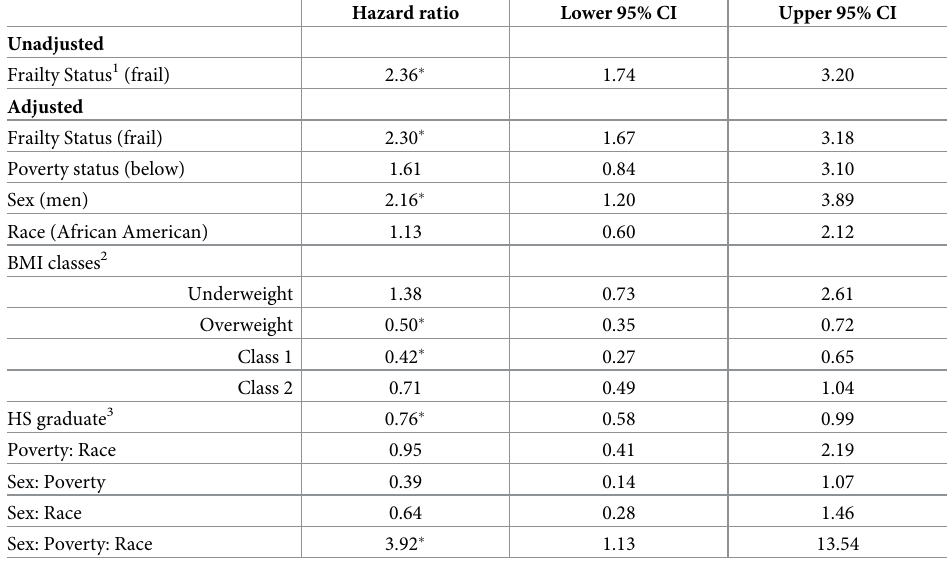
Table 4. All-cause mortality hazard ratios and 95% confidence intervals by frailty status and